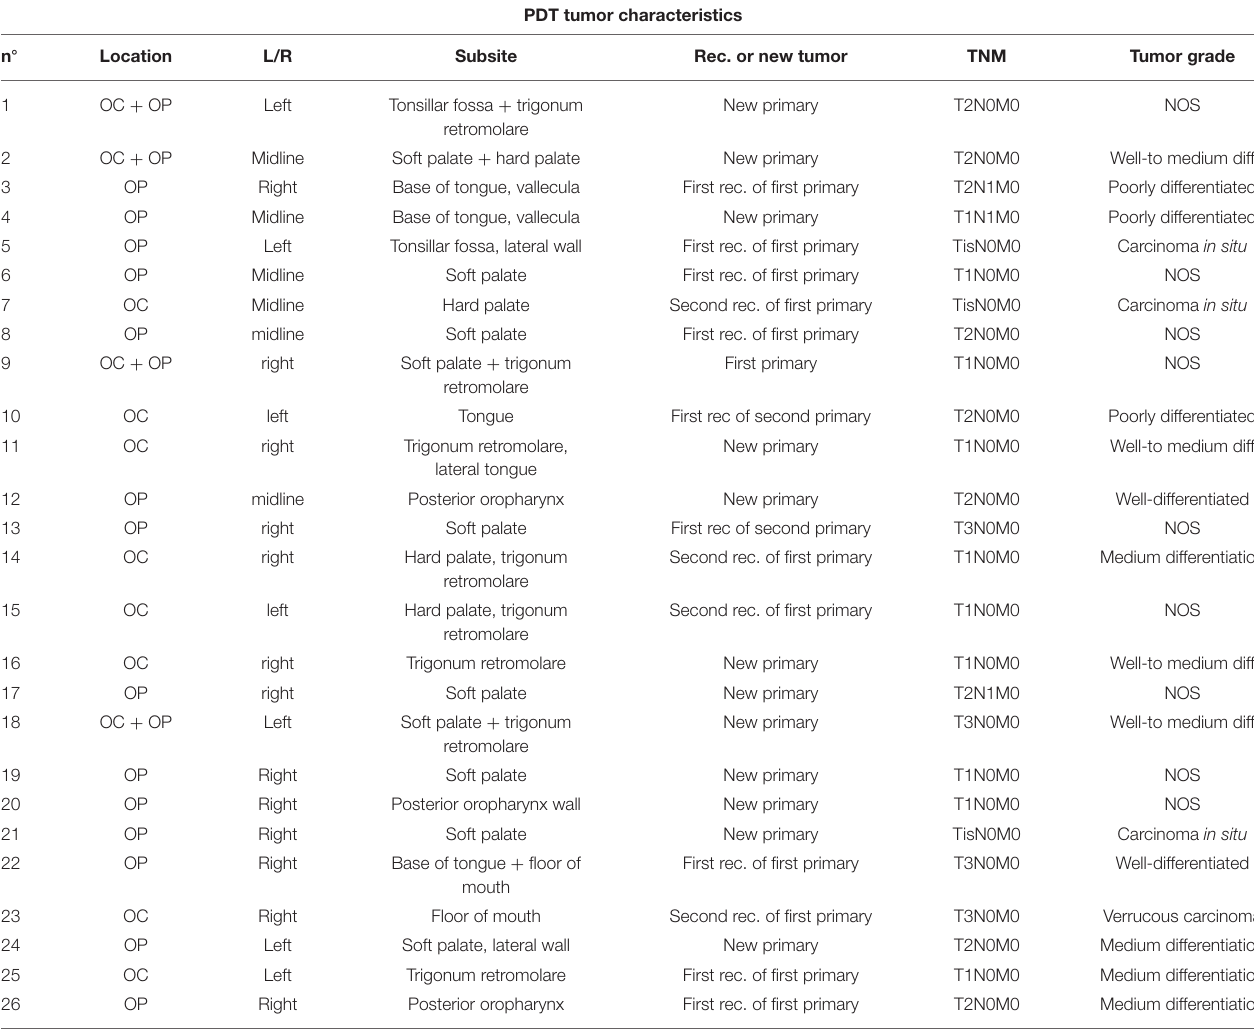
TABLE 4 | Tumor specific characteristics of 26 patients receiving photodynamic therapy for cancer of the oral cavity or oropharynx with oral cavity